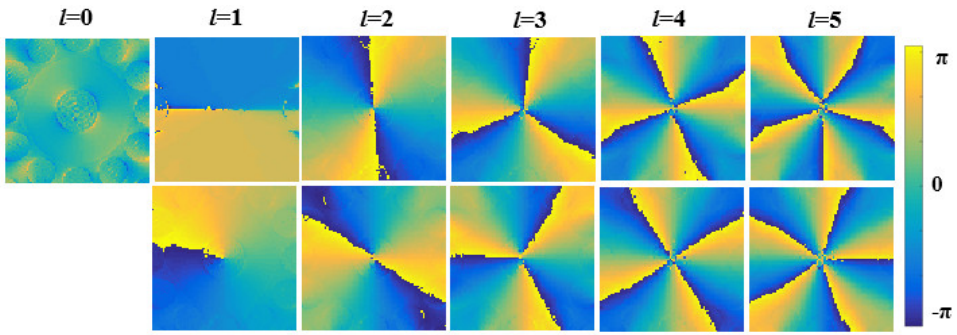
Figure 6. The phase distribution of the OAM mode in the terahertz OAM PCF.